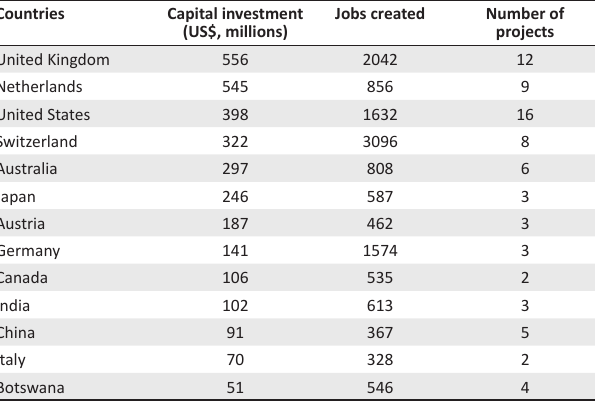
TABLE 2: Agricultural foreign direct investment inflows to South Africa according to investor country, 2003–2014. Countries Capital investment (US$,